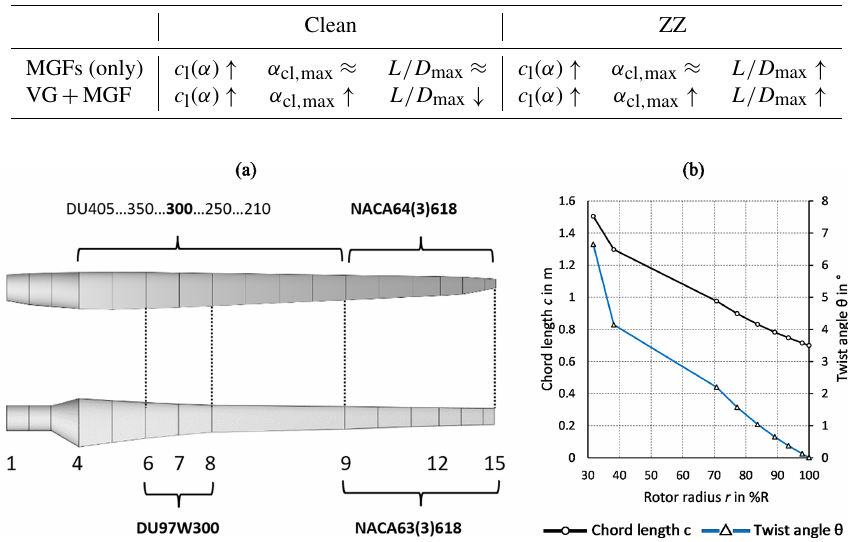
Table 8. Performance evaluation of MGFs and VGs based on the wind tunnel tests of the NACA63(3)618 and the DU97W300. ↑ for increase, ≈ for similar and ↓ for decrease.